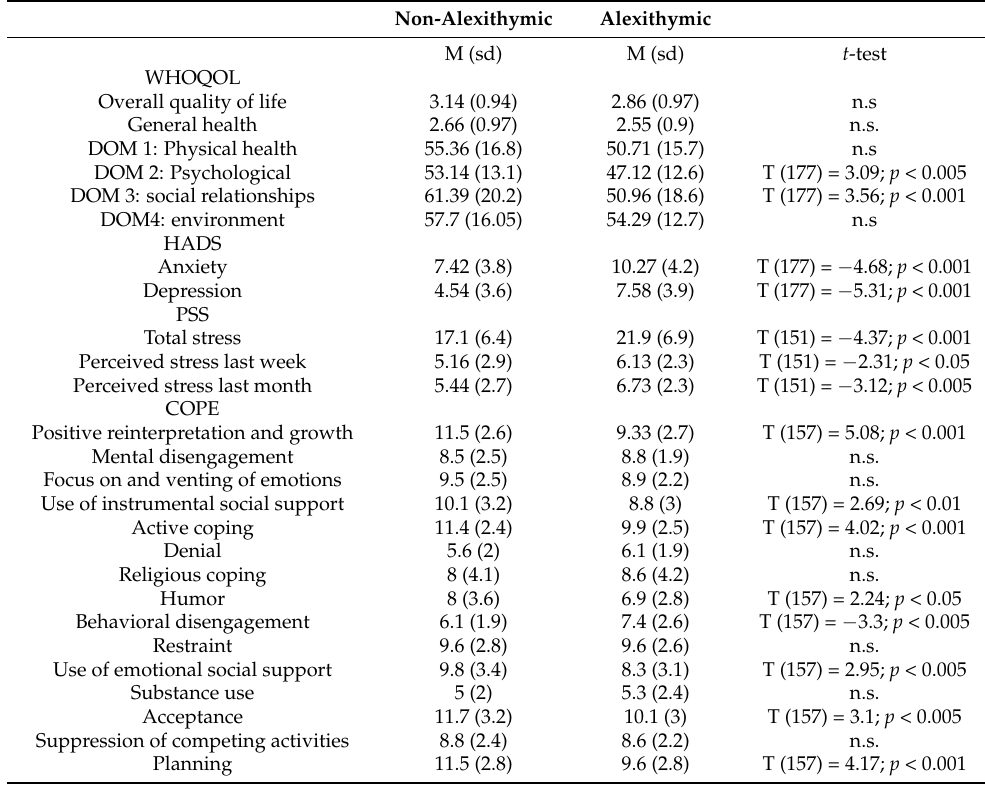
Table 5. Psychological variables comparison between A and NA groups by t